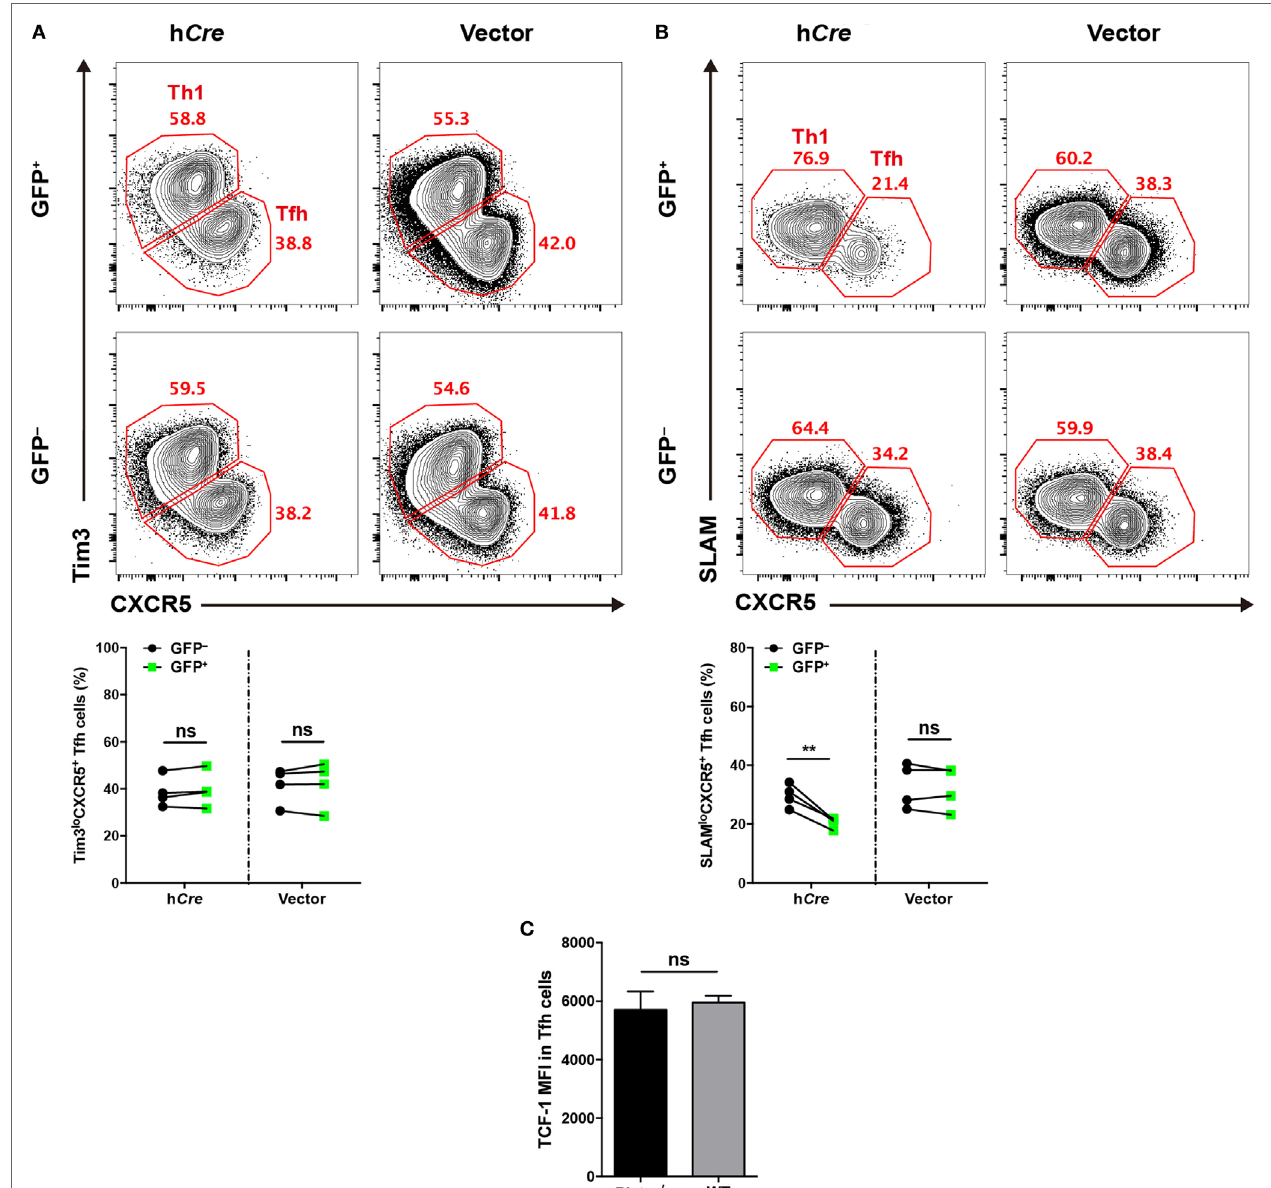
FigUre 3 | mTOR complex 2 is selectively required for late follicular helper CD4 + T (T FH ) differentiation, but not early induction. (a,B) Rictor fl/fl -SMARTA cells were transduced with retrovirus expressing humanized- Cre (h Cre ) or empty vector (vector) and then transferred cells into recipients (CD45.2 + ) and subsequently infected with lymphocytic choriomeningitis virus (LCMV). Flow cytometry of T FH differentiation in Rictor fl/fl -SMARTA cells transduced (GFP + ) with h Cre or vector, or non- transduced (GFP − ) at day 3 (a) and 8 (B) after infection ( n = 4 mice per group). (c) T cell factor-1 expression in early differentiated T FH cells at day 3 after infection. Rictor − / − or WT SMARTA (CD45.1 + ) cells were adoptively transferred into naive C57BL/6J (CD45.2 + ) mice, following intravenously infection with 2 × 10 6 plaque- forming units of LCMV and analyzed at day 3 after infection ( n = 4–6 mice per group). ns, not significant, ** p < 0.01 [paired two-tailed t -test (a,B) , unpaired two-tailed t -test (c) ]. Data are representative of two (a–c) independent experiments. Error bars are SEM (a–c)